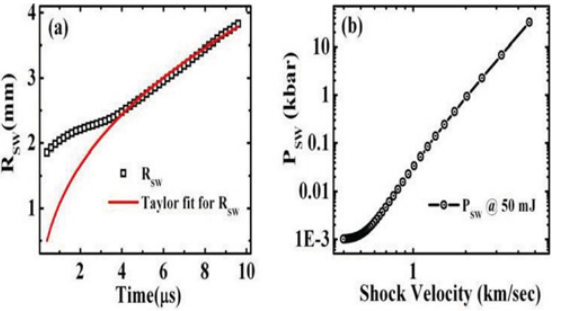
Figure 3. (a) SW location data showing radius of curvature of shock front (R SW ) and solid line showing the curve fit to Taylor solution. (b) P-U Hugoniot of air at 50mJ laser